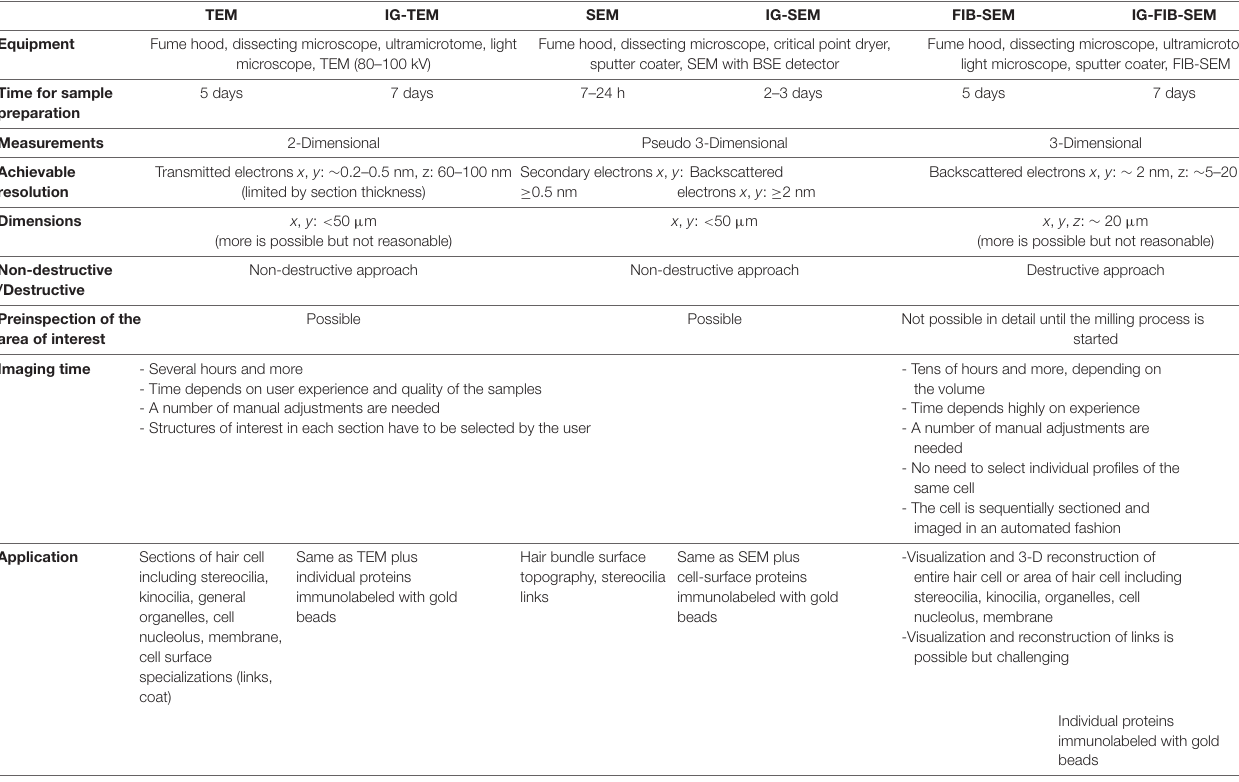
TABLE 1 | Key parameters of different EM